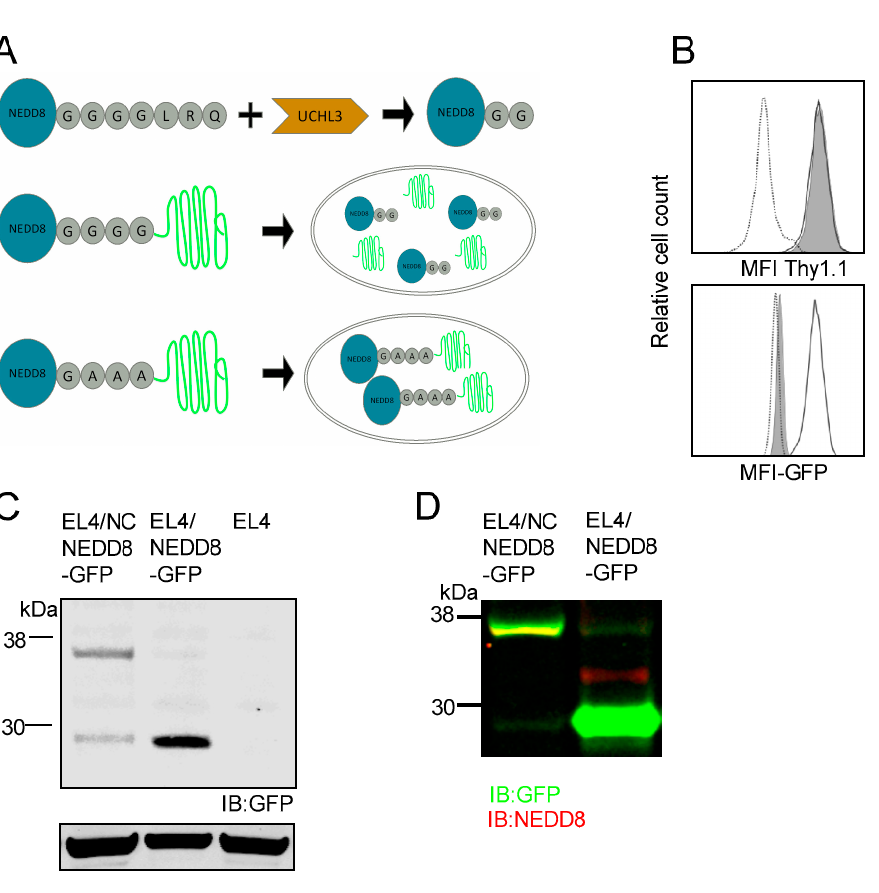
Figure 1. Fusion of NEDD8 to GFP leads to decreased GFP in stably transfected cells. ( A ) Cartoon representation of the components of the constructs. During normal NEDD8 processing, UCH-L3 cleaves between the second and third glycine residues releasing the active NEDD8 molecule. NEDD8 fused to GFP should be cleaved in the same manner as the wildtype NEDD8 protein, however, mutation of the 3 glycine residues to alanine residues will result in a fusion protein where NEDD8 is bound, in a non-cleavable manner to GFP. ( B ) Each NEDD8-GFP construct was cloned into an IRES expression vector containing a Thy1.1 reporter DNA sequence. EL4 cells (dotted trace) were stably transfected with either wildtype and cleavable NEDD8-GFP (solid trace) or non-cleavable (NC) NEDD8-GFP constructs (shaded histograms). Each cell type was analyzed by flow cytometry for both Thy1.1 expression (top histogram) and GFP (bottom histogram). ( C ) Western blot analysis of EL4/NEDD8-GFP and EL4/NC NEDD8-GFP cell lysates. Following SDS-PAGE and blotting onto nitrocellulose, membranes were probed with either mouse monoclonal antibodies against GFP or rabbit poly-clonal antibodies against actin and appropriate secondary antibodies. ( D ) Two-color immunoblot of EL4/NEDD8-GFP and EL4/NC NEDD8-GFP cell lysates. After SDS-PAGE and blotting, nitrocellulose membranes were probed simultaneously with mouse monoclonal antibodies against GFP and rabbit polyclonal antibodies against NEDD8. Antigen-antibody complexes were detected using goat anti-rabbit IRDye 680 CW (red), and goat anti-mouse 800 CW (green) secondary antibodies. Yellow regions correspond to simultaneous fluorescence in both channels. All Western blot images were cropped to show relevant